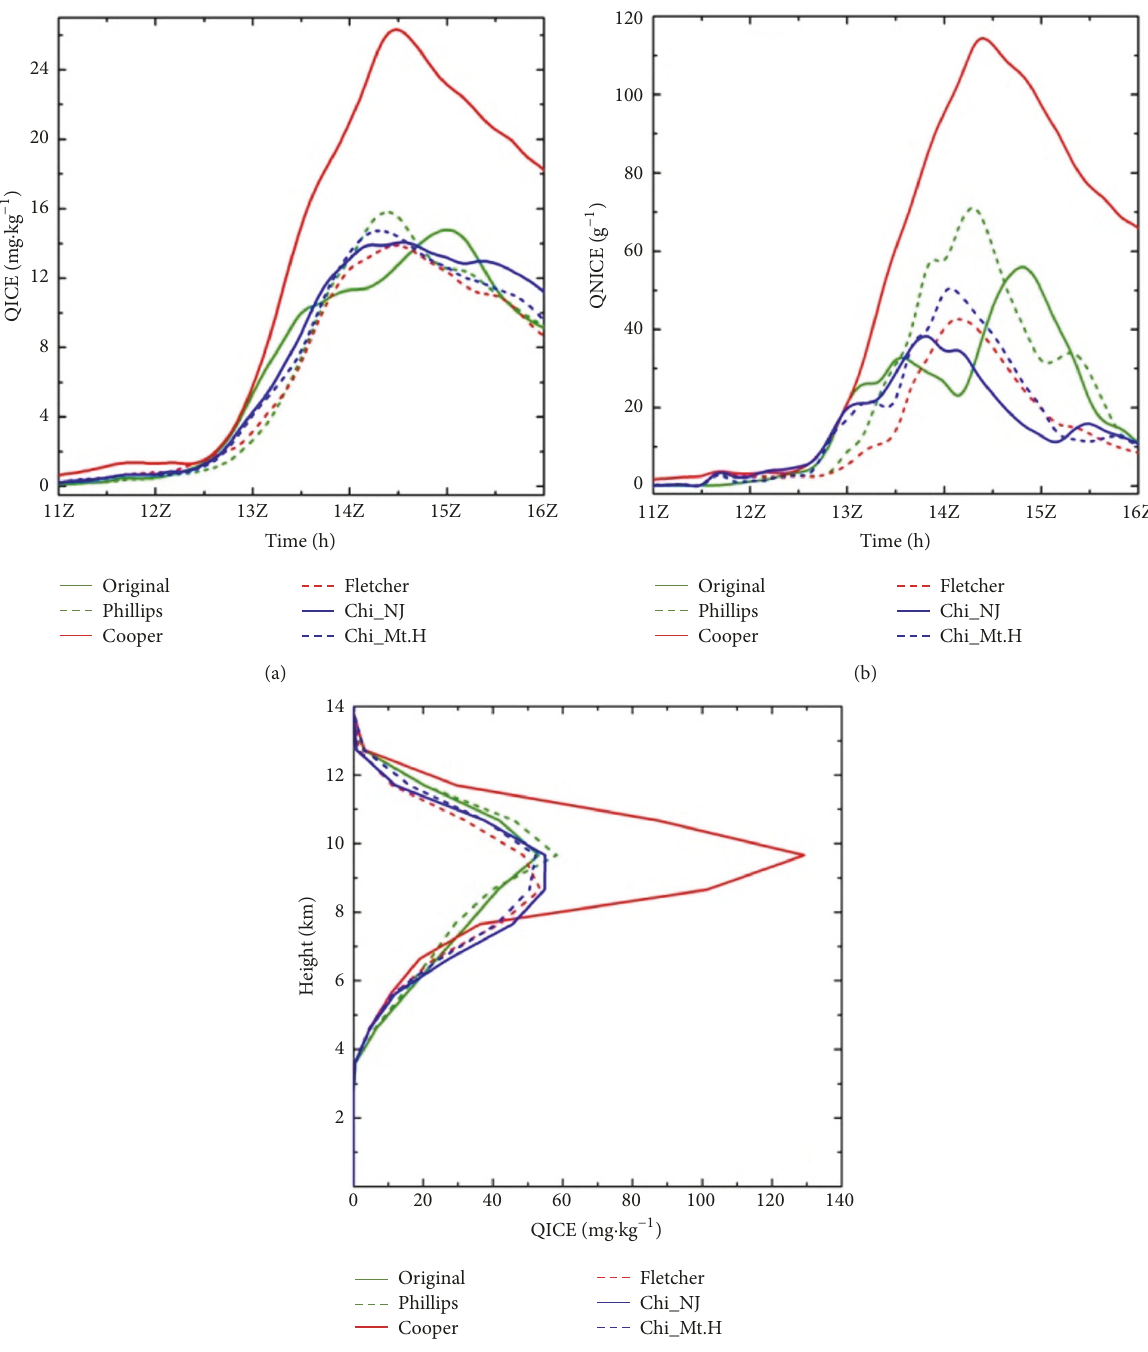
Figure 6: Variation of the regional (118.7 ∘ E–120.2 ∘ E, 29.4 ∘ N–30.4 ∘ N) average mixing ratio ((a) unit: mg ⋅ kg −1 ) and the number concentrations ((b) unit: 10 3 L −1 ) of ice crystals with time and the variation of the regional average mixing ratio with height from the hail cloud generation to the extinction period ((c) unit: mg ⋅ kg −1